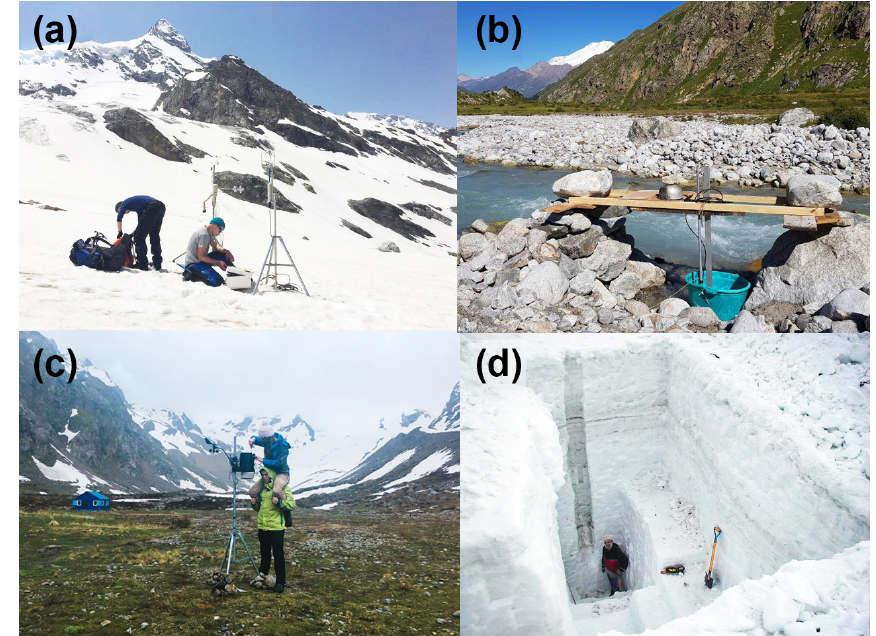
Figure 3. (a) Campbell meteorological complex with a set of Kipp & Zonen radiometers and a Gill three-component acoustic anemome- ter at the Djankuat glacier AWS 1 location; (b) the construction of the Djankuat gauging station; (c) Djankuat base camp AWS – Davis meteorological station. (d) Snow density measurement in a snow pit at the stake 49.